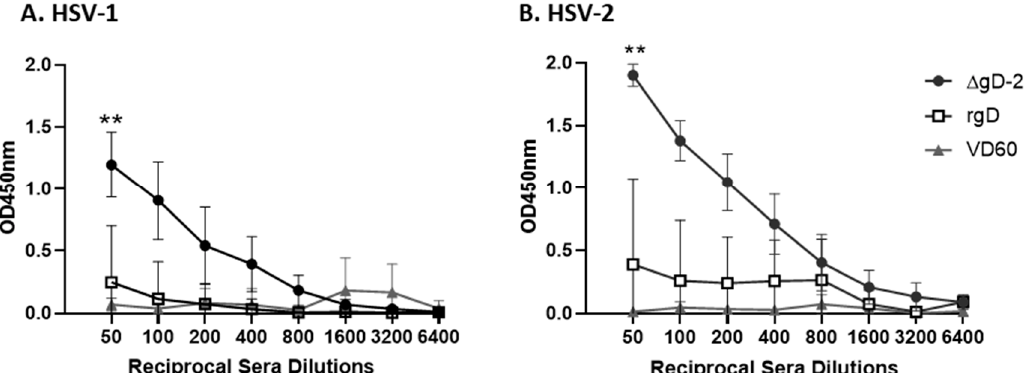
Figure 1. C1q binding of immune serum in mice vaccinated with ∆ gD-2, adjuvanted recombinant gD or VD60 cell lysate. Serial 2-fold dilutions of heat-inactivated immune serum (1:50–1:6400) were assayed for ability to bind C1q using an ELISA with ( A ) HSV-1 B 3 x1.1-infected Vero cells or ( B ) HSV-2(G) infected Vero cells. Results are shown as mean ± standard deviation (SD of the optical density units (OD450 nm) at each dilution ( n = 9–10 mice per group) and the area under the curve was compared to VD60 controls using unpaired t -test with Welch’s correction (** p < 0.01). There was no significant difference comparing C1q binding of adjuvanted rgD immune serum and VD60 controls.